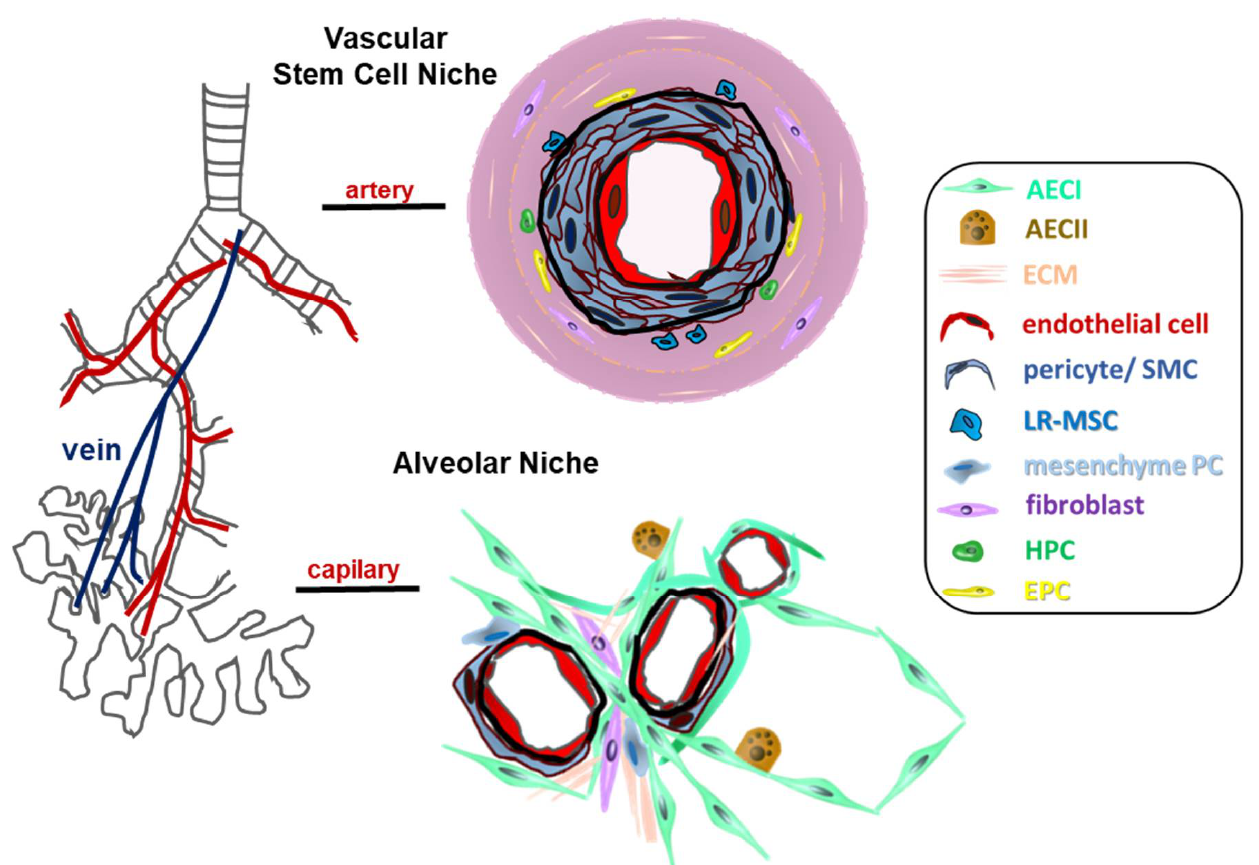
Figure 2. Mesenchymal (stem) cell niches within lungs. The vascular system is hierarchically organized and, thus, is composed of large, medium-sized, and the smallest blood vessels. Basically, a three-layered structure can be named: the innermost intima facing the vessel lumen, the middle media (tunica media) where vascular smooth muscle cells are oriented in a circle around the vascular lumen and form numerous layers (depending on vessel type, size, and location in the body), and the outermost adventitia. The latter one representing the interface between vessel wall and surrounding tissue, namely the perivascular space(s) that vary in dimension according to the type of blood vessel [105,106]. In contrast to the adventitia, the perivascular space does not display the circular organization. Perivascular cells are in close contact with the adventitia, and the adventitia and periadventitial/perivascular cells function in concert [107]. Lung-resident mesenchymal stem cells (LR-MSCs; blue) were shown to be predominantly localized within the vascular wall of larger lung blood vessels, the adventitial stem cells niche. Within that vascular stem cell niche, other vascular wall-resident stem and progenitor cells can be found: endothelial progenitor cells (EPCs depicted as yellow cells) and hematopoietic stem cells (HSCs depicted as green cells). The alveolar (stem cell) niche represents a combination of the vascular niche with the airway niche. Different mesenchymal cells, their respective progenitors, as well as pericytes with similar MSC morphologies and shared expressions of classical MSC markers were known to reside here within the interstitium between epithelial and endothelial cells (mesenchyme progenitor cells (PC), depicted as light blue